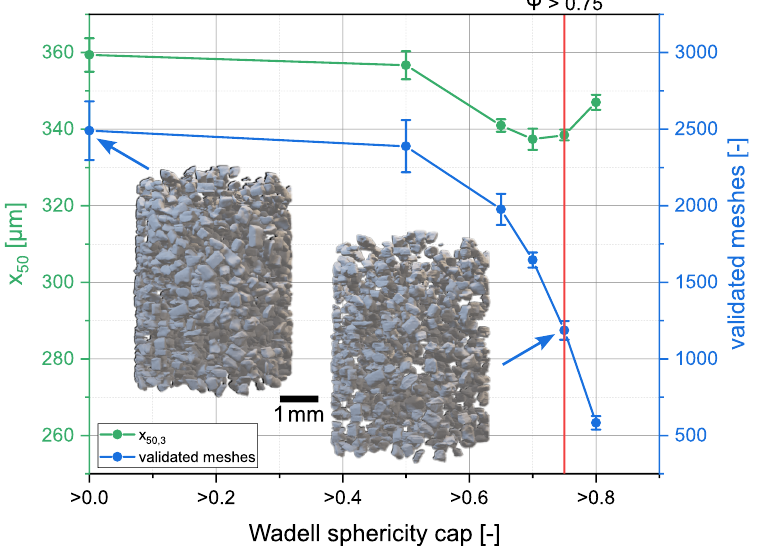
Figure 5. Evolution of the x 50,3 and number of validated meshes when allowing only particles above a certain Wadell sphericity. For demonstration purposes, sucrose with a sieve fraction of 250–400µm was used. The same sample was measured three times. The sample was taken from, and put back into, the sampler between the